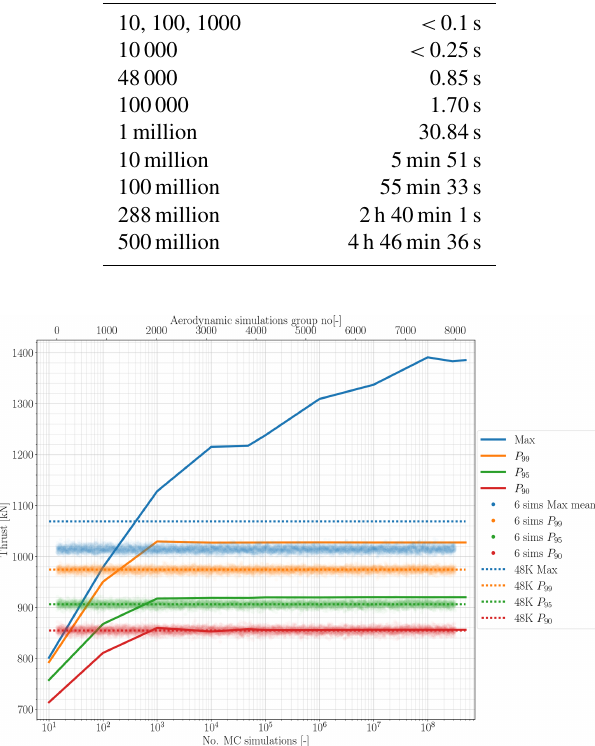
Figure 10. Maximum load and percentile comparison between the aerodynamic simulation reference case, the MCSs, and group aero- dynamic simulations for thrust.